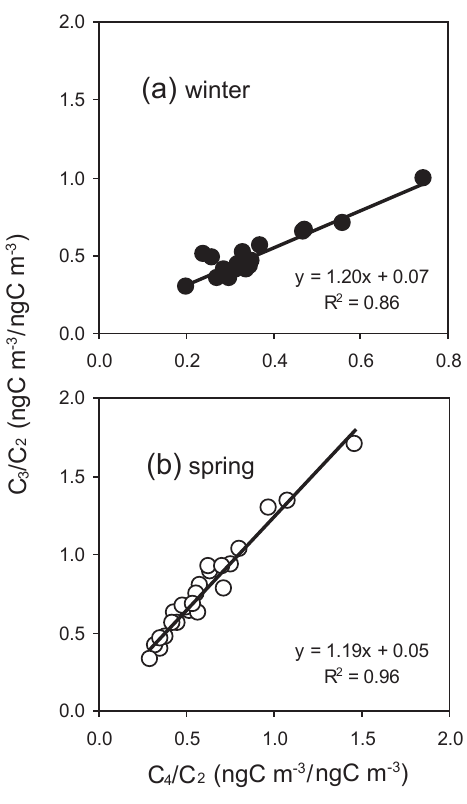
Fig. 4. Concentration ratios of malonic (C 3 ) and succinic (C 4 ) acids to oxalic acid (C 2 ) in PM 10 from Baoji City during winter and spring (Data including the urban and suburban samples).